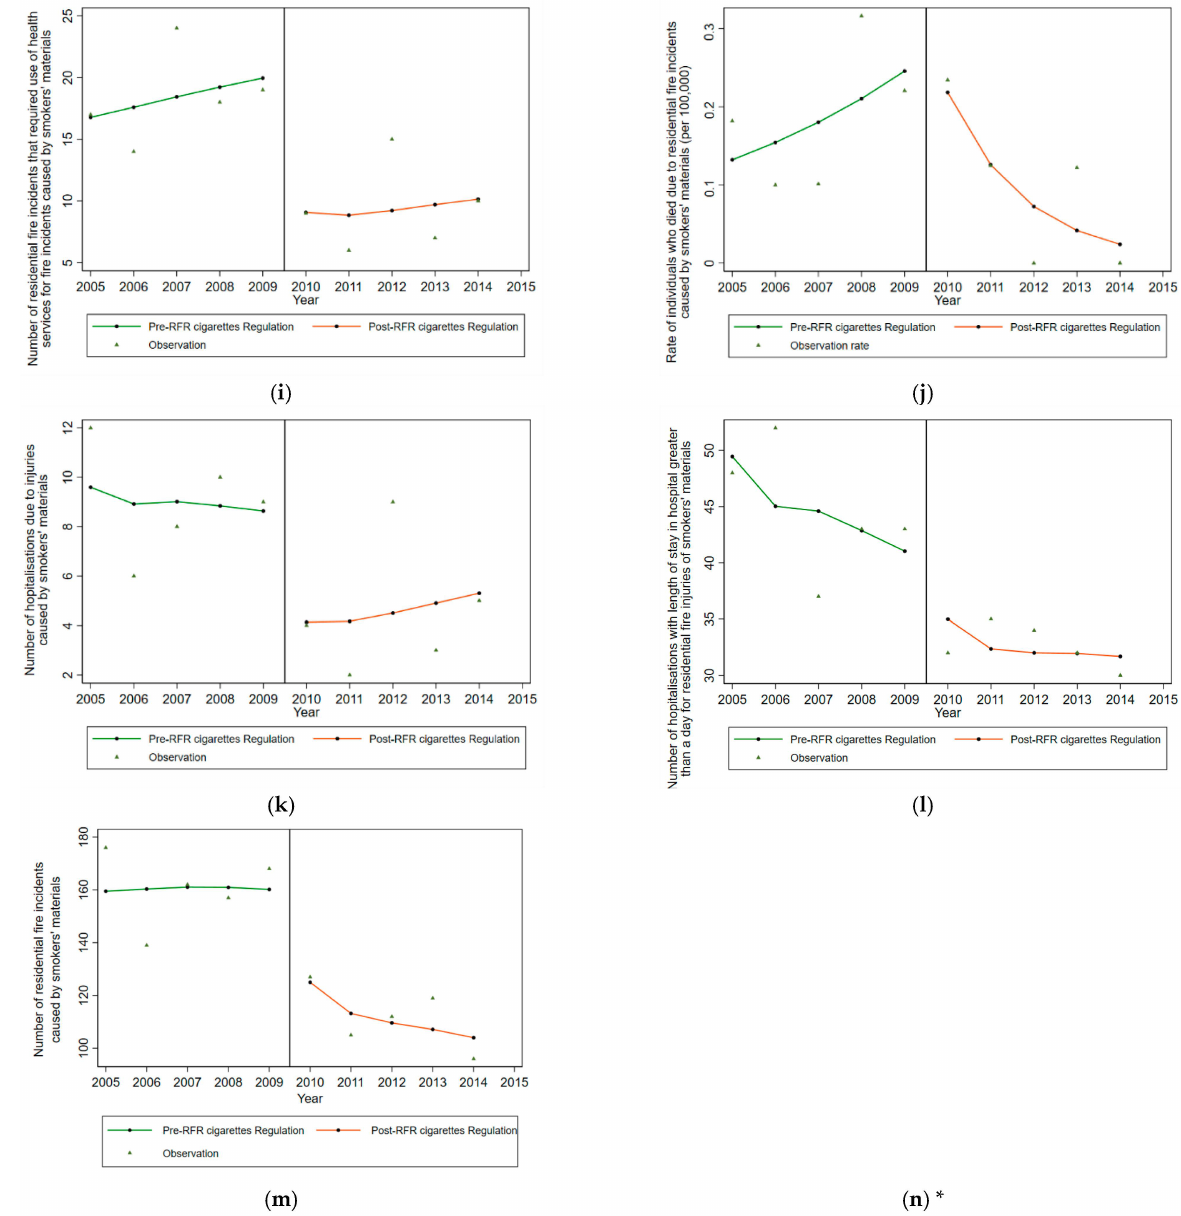
Figure 2. Estimated effect of RFR cigarettes regulation in the number of smokers’ materials fires using linked data, NSW, Australia, 2005–2014. ( a ) Number of residential fire incidents caused by smokers’ materials—abandoned cigarettes. ( b ) Number of residential fire incidents caused by smokers’ materials—ignited by falling asleep. ( c ) Number of residential fire incidents caused by smokers’ materials—in sleeping area. ( d ) Number of residential fire incidents caused by smokers’ materials—fire brigade spent more than 41 min. ( e ) Number of residential fire incidents caused by smokers’ materials—more than 1% of the property was involved in fire when brigade arrived (median percentage of property involved in fire). ( f ) Number of residential fire incidents caused by smokers’ materials—fire incidents that damaged structure and contents of the property. ( g ) Number of residential fire incidents caused by smokers’ materials—fire incidents that their flame damage extended beyond the room of fire origin. ( h ) Number of residential fire incidents caused by smokers’ materials—monetary value of damage loss greater than AUD 1000. ( i ) Number of residential fire incidents caused by smokers’ materials—health service utilisation. ( j ) Residential fire incidents caused by smokers’ materials—rate of individuals who died (per 100,000). ( k ) Number of